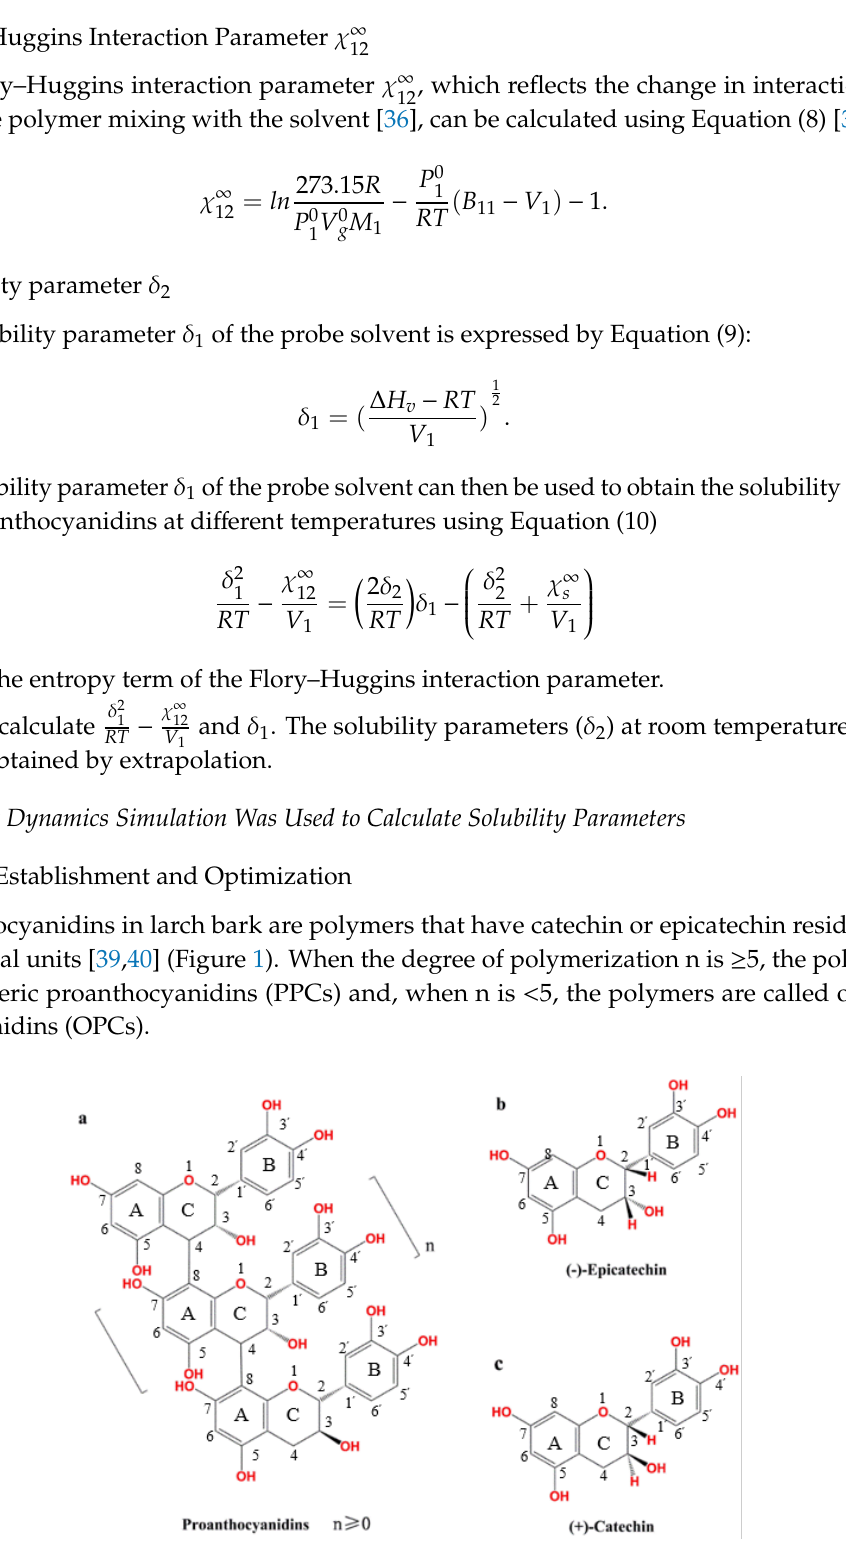
Figure 1. Chemical structure of proanthocyanidins: ( a ) Proanthocyanidins; ( b ) epicatechin; ( c ) catechin.